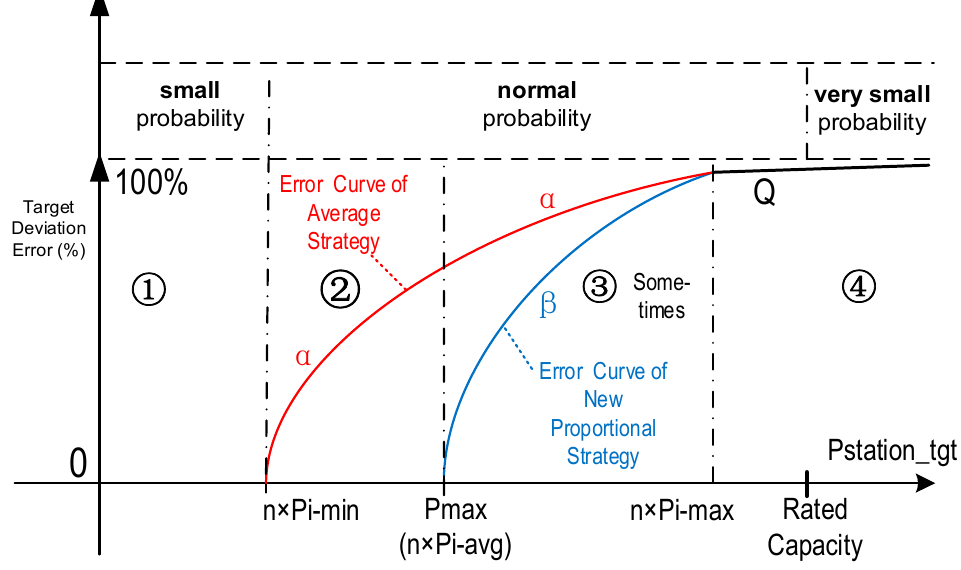
Figure 4. Deviation error curves of the average and proportional distribution strategies and the probability of error occurrence.